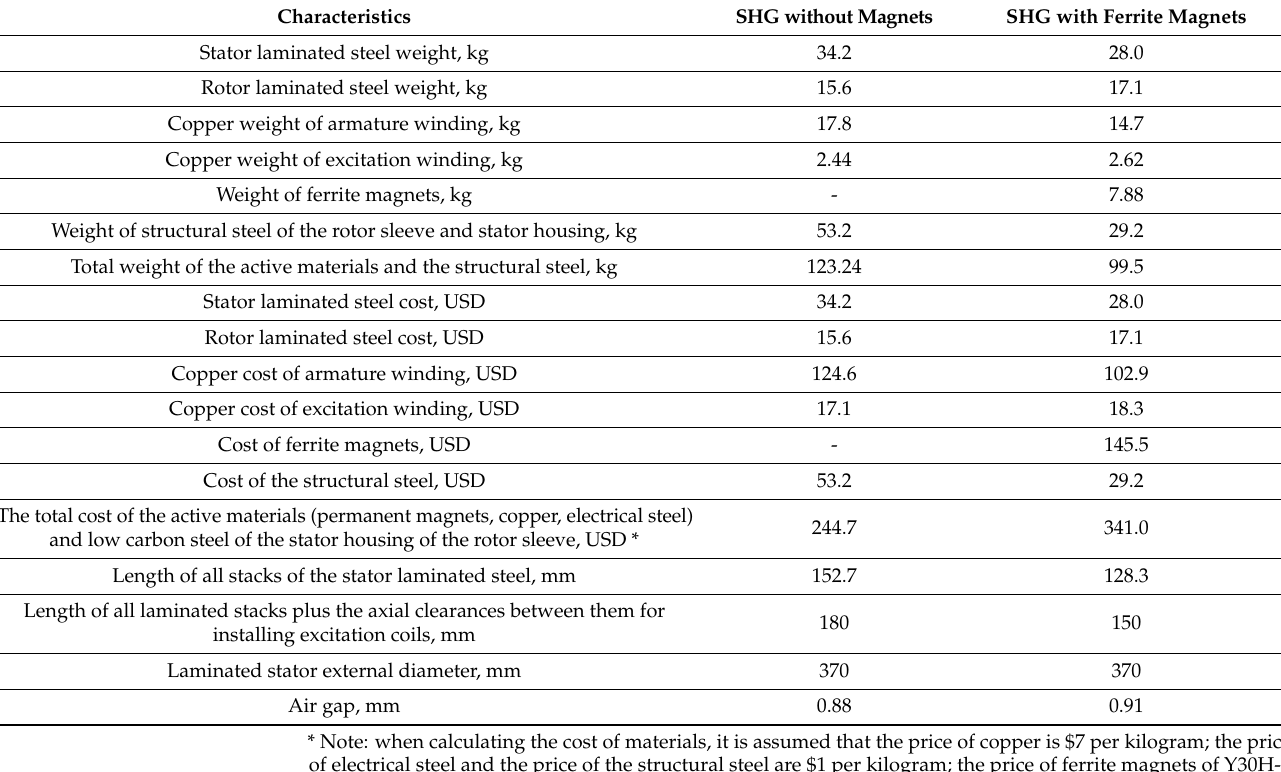
Table 5. Comparison of the cost and geometric characteristics of the considered